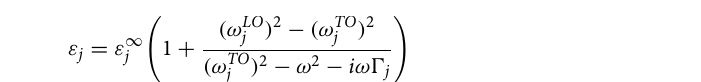
where j represents principal axis direction (i.e. x , y and z ) of the α - MoO 3 and α - V 2 O 5 crystals. The directions x , y and z correspond to [100], [001] and [010] crystallographic directions respectively. Here ε j is the principal component of dielectric tensor, whereas ε ∞ j , ω LO j and ω TO j represent high-frequency dielectric constant, frequency of longitudinal optical (LO) and transverse optical (TO) phonons, respectively in the j direction. Lastly, Ŵ j repre- sents the line-width of oscillations in the respective directions. The values of these parameters have been taken from the literature 34,37 and are tabulated in Sec. S2 of supplementary information. The real part of the principal components of the dielectric tensors of α - MoO 3 and α - V 2 O 5 are plotted as a function of frequency in Fig. 1b,c 1010 cm − 1 in atleast one crystallographic direction. Reststrahalen Bands 1–3 lie in the range of 545–850 cm − 1 ,